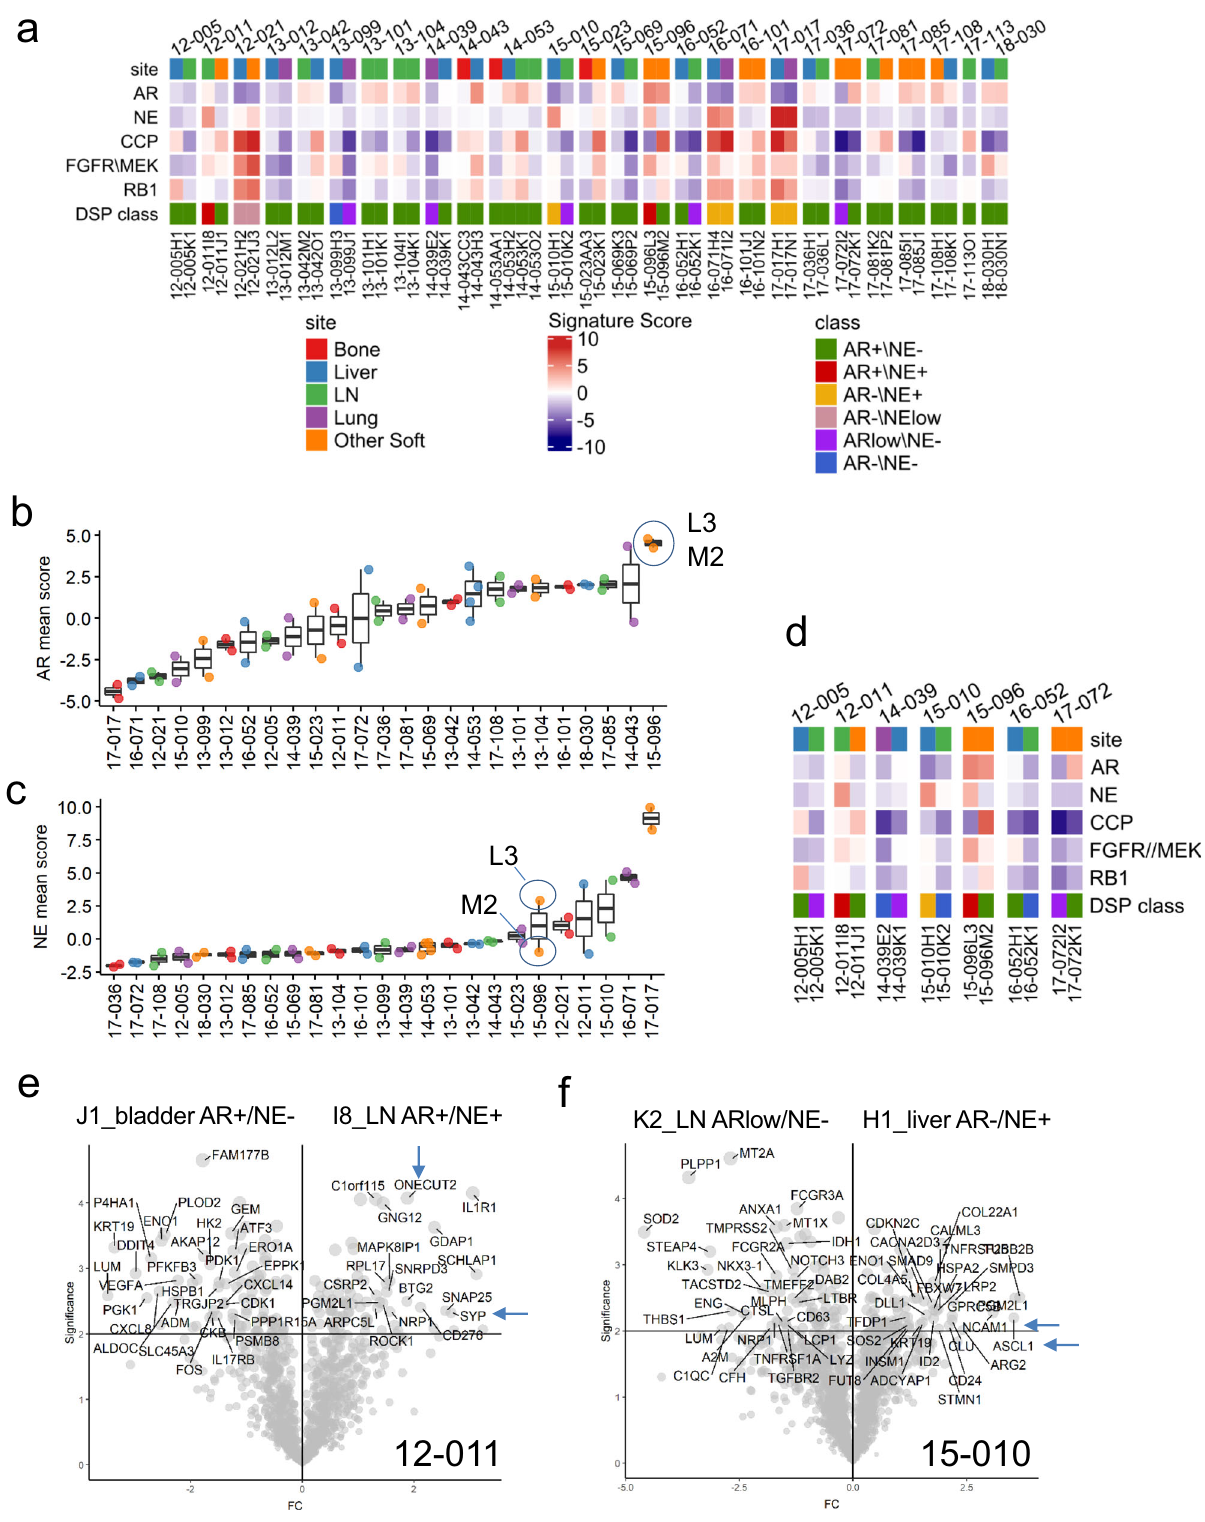
(Fig. 6a). For two patients, 16 – 052 and 17 – 081, tumors were discordant with respect to AR-V7 status. We next used DSP to further evaluate the intratumoral heterogeneity of AR-V7. We designed a series of barcoded oligonucleotide probes with speci- fi city for each of the exons comprising the full-length AR gene and cryptic exon 3 (CE3) that comprises the AR-V7 transcript (Fig. 6b). Notably, when evaluating AR-V7 expression in the